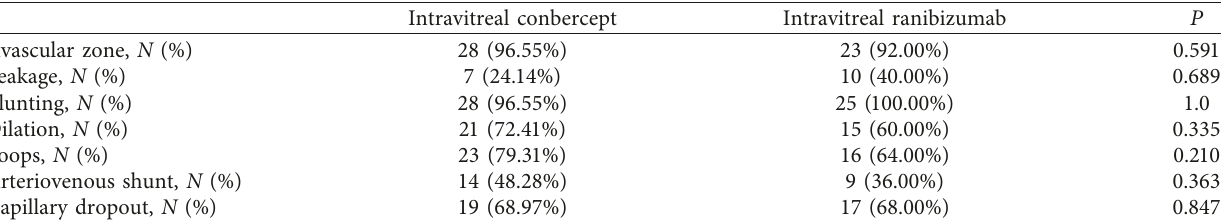
Table 3: Number of eyes (%) with peripheral retinal vasculature abnormalities for ROP infants receiving intravitreal conbercept or